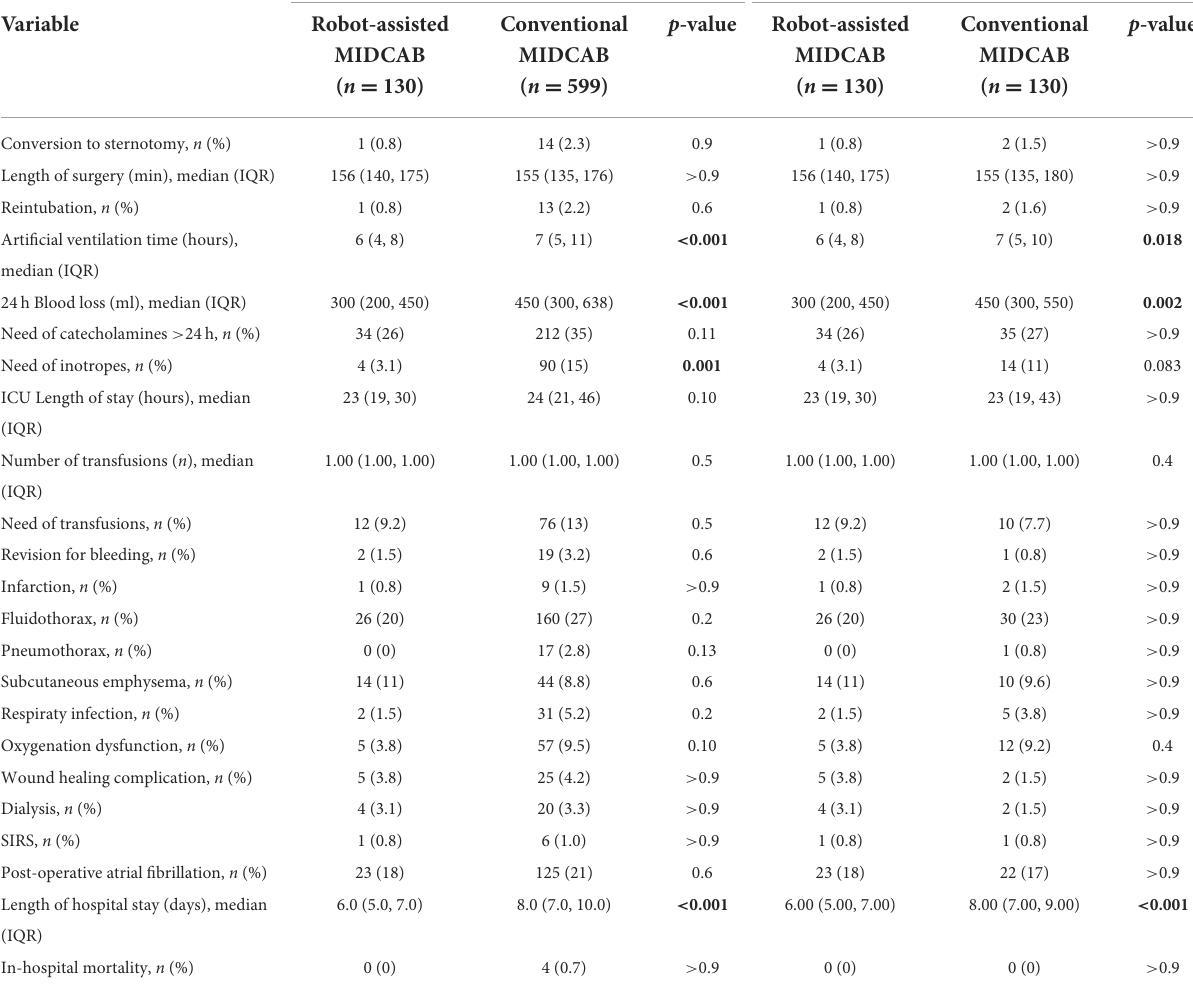
Pre-matching Post-matching